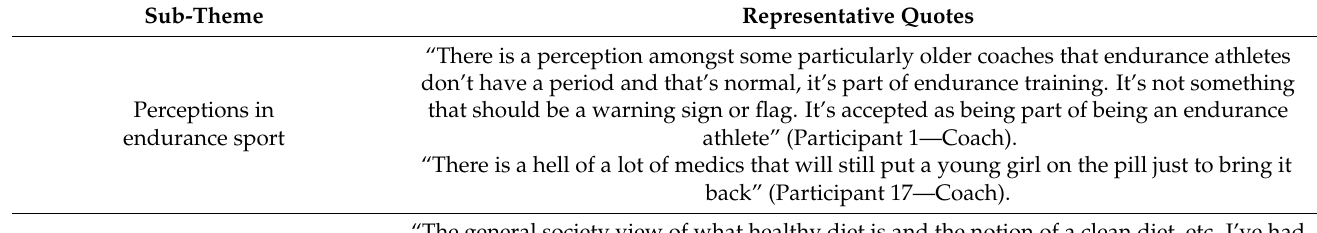
Table 6. Theme: Gaps in